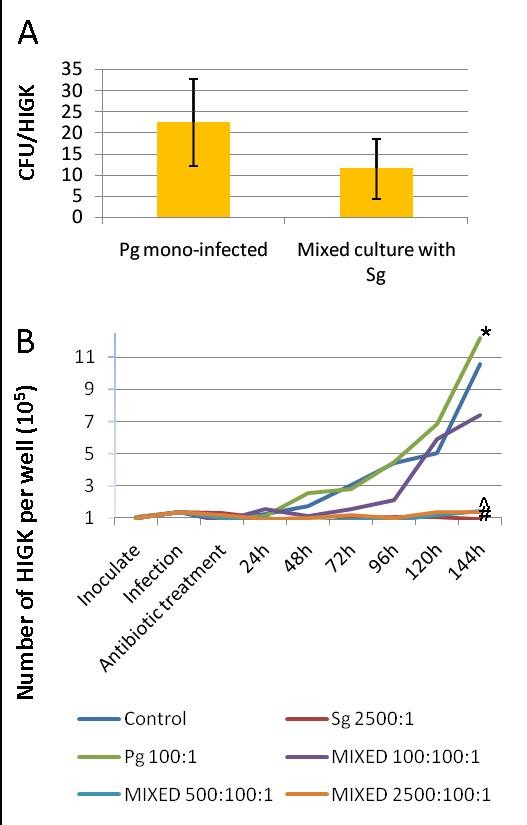
Accelerated HIGK proliferation upon infection with P. gingivalis is inhibited in co-culture with S. gordonii. A) Total interaction and invasion levels determined by measuring the total numbers of P. gingivalis associated with HIGK cells by live counts in mono-(Pg) and in mixed infection (Mixed) with S. gordonii at the highest MOI. Results are the mean of three experiments. B) HIGK cells at a low confluency were co-cultured with single and complex mixtures of bacteria and cultured for up to 144 hours. Labels: Control, uninfected HIGK; Sg, S. gordonii; Pg, P. gingivalis; MIXED, co-infection with S. gordonii and P. gingivalis at different multiplicity of infection (MOI). All cell counts were performed in triplicate and all experiments were repeated twice. * p > 0.05 P. gingivalis vs non-infected controls; #p < 0.05 S. gordonii vs. non-infected controls; ^p < 0.05 S. gordonii co-infection with P. gingivalis (2500:1) vs. non-infected controls (p < 0.05) by ANOVA with Dunnett's Multiple Comparison Test.